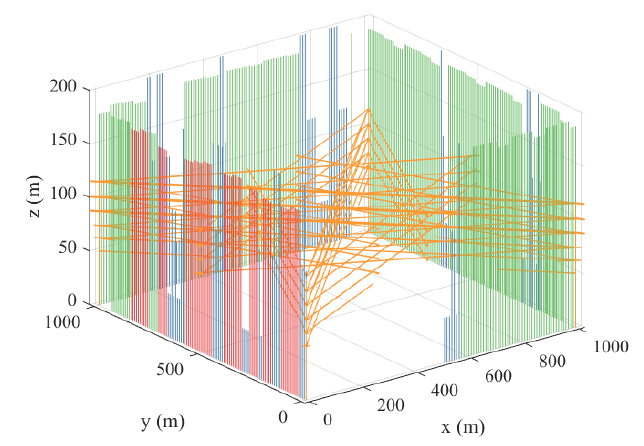
Figure 5. The QUAV trajectories of the flight mode (under the standard conditions) for generating the historical data. The blue and yellow lines represent the hover and horizontal flight, respectively. The red lines represent the climb flight, and the green lines represent that the QUAV climbs for a while and then